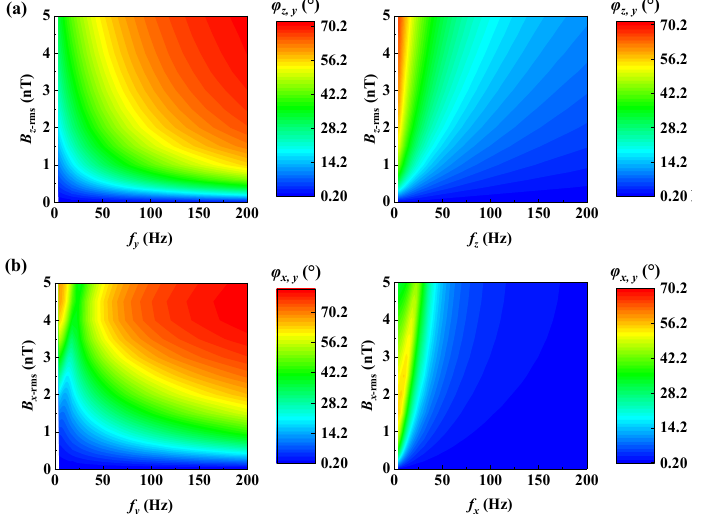
Figure 5. The amplitudes and coupling coefficients dependence on the frequency of the sensitive and interference field under varied interference field amplitude. ( a ) A y and C z , y dependence on f y ; C z , y dependence on f z when B x 0 was applied. ( b ) A y and C x , y dependence on f y ; C x , y dependence on f x when B z 0 was applied.